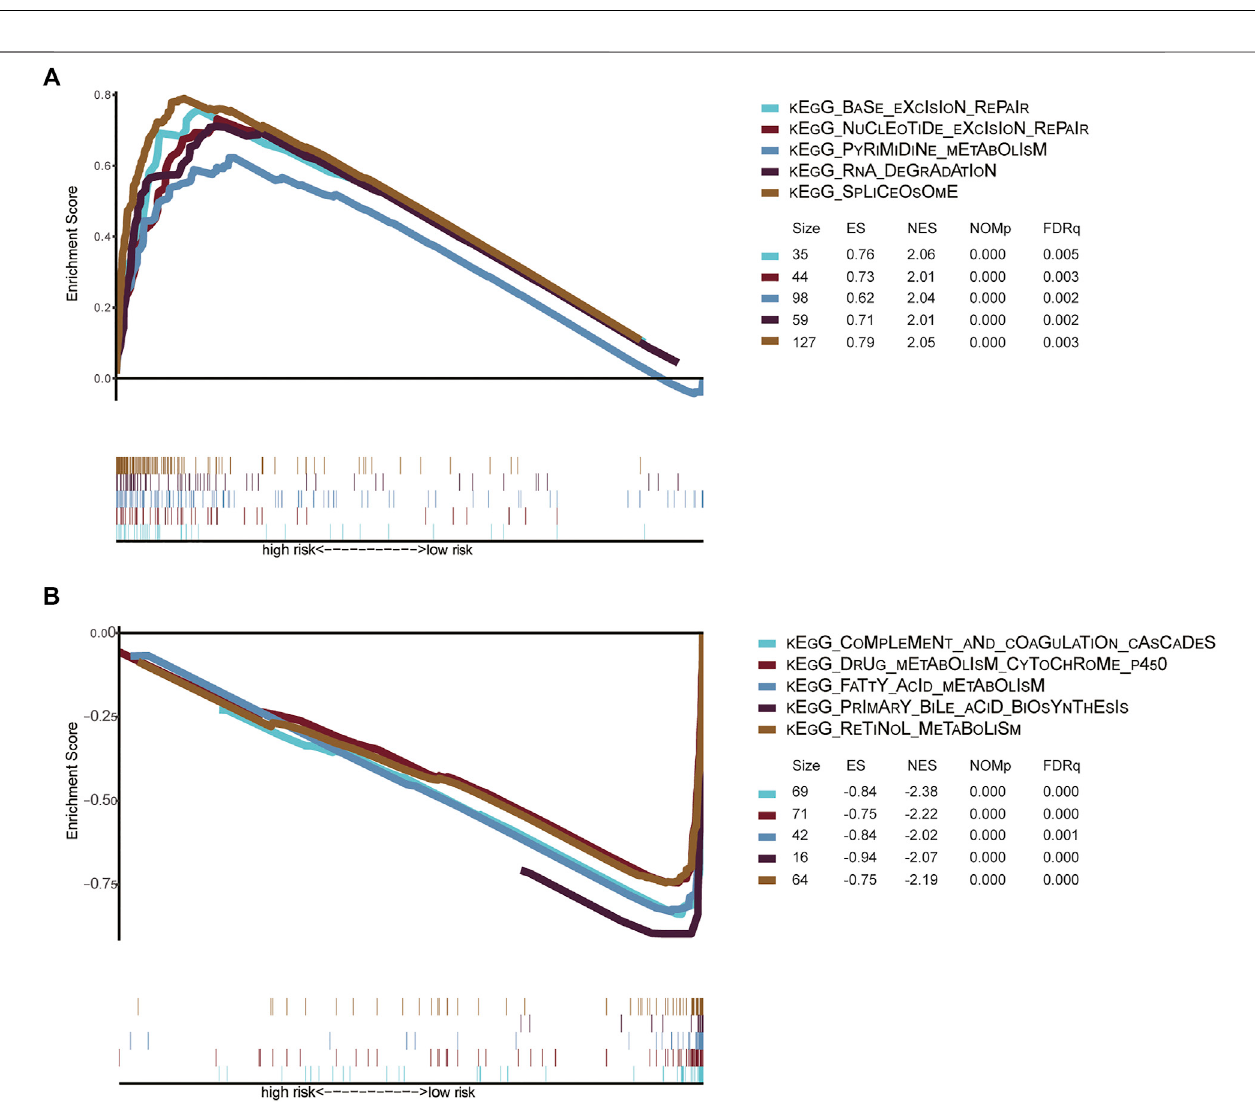
FIGURE9|(A) Signalingpathwaysenrichedinhigh-riskgroupsidenti fi edbyGSEA (B) Signalingpathwaysenrichedinlow-riskgroupsidenti fi edbyGSEAGeneset enrichmentanalysisofhigh-riskandlow-riskgroupsintheTCGAHCC dataset. KEGG,Kyoto Encyclopedia ofGenesandGenomes;TCGA,TheCancerGenomeAtlas; GSEA, gene set enrichment analysis; ES, Enrichment score; NES, Normalized enrichment score.